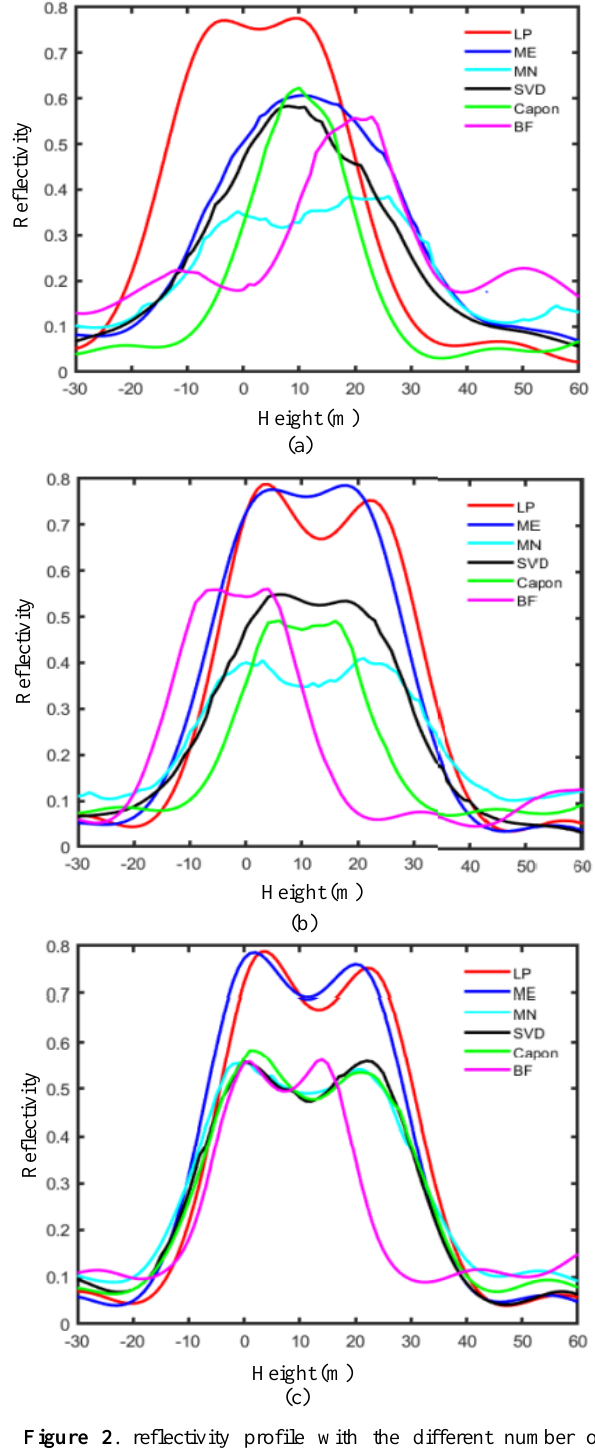
Figure 2 . reflectivity profile with the different number of simulated data. (a) 19 observations. (b) 31 observations. (c) 65